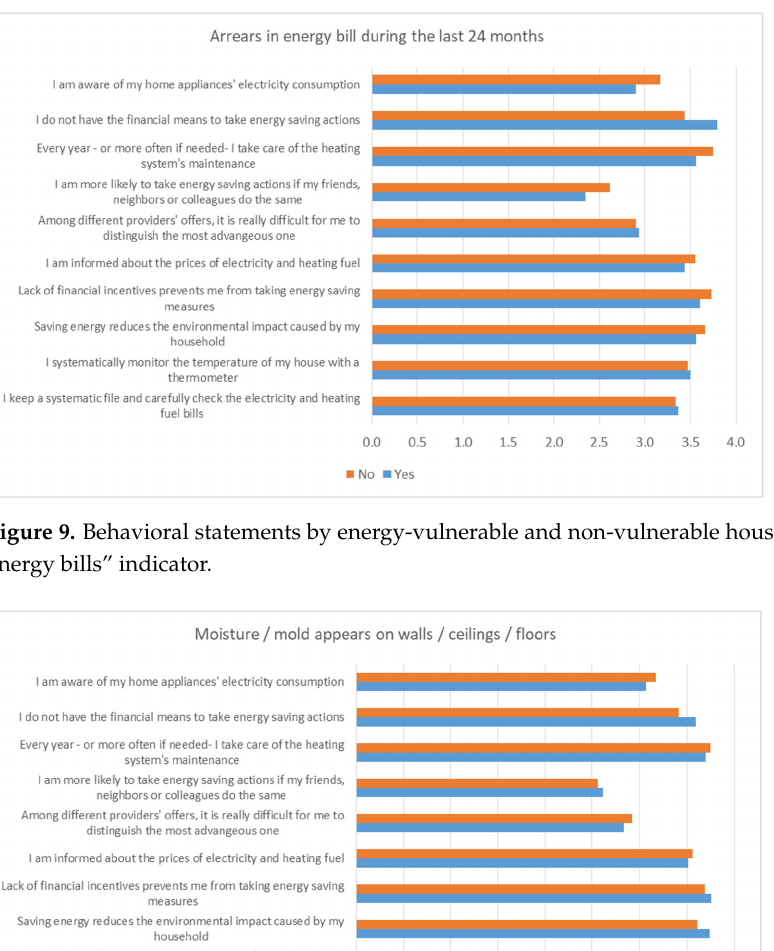
Figure 8. Behavioral statements by energy ‐ vulnerable and non ‐ vulnerable households—“inability to keep house adequately warm” indicator.